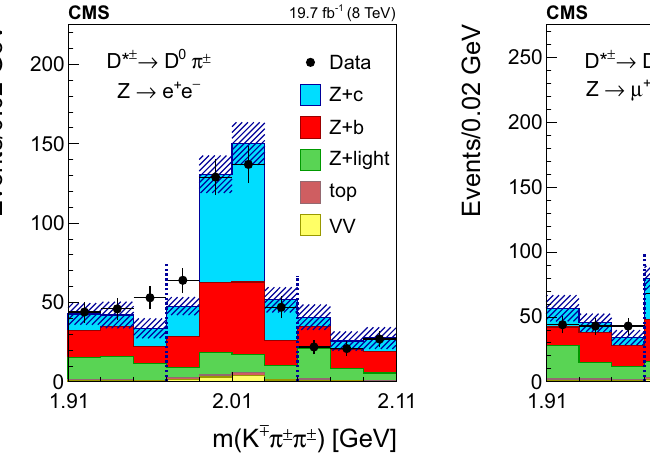
mated with the simulated samples. The two dashed, vertical lines mark the mass range of the signal region. Vertical bars on data points repre- sent the statistical uncertainty in the data. The hatched areas represent the statistical uncertainty in the MC